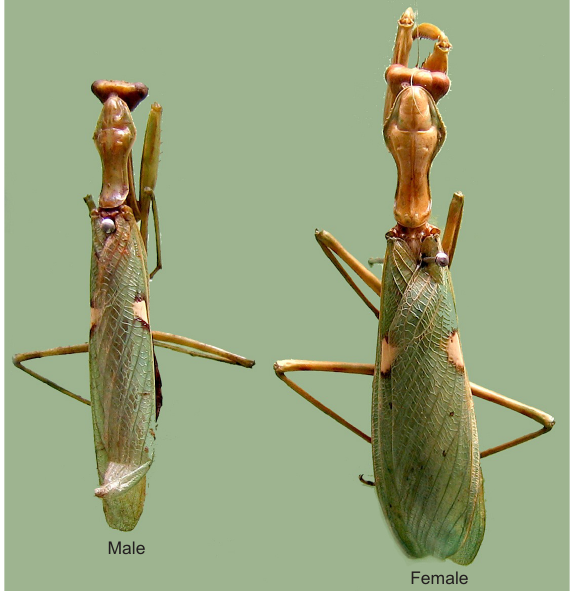
with blackish apices; discoidal spines pale brown on inner side. Meso- and metathoracic trochanters light brown.